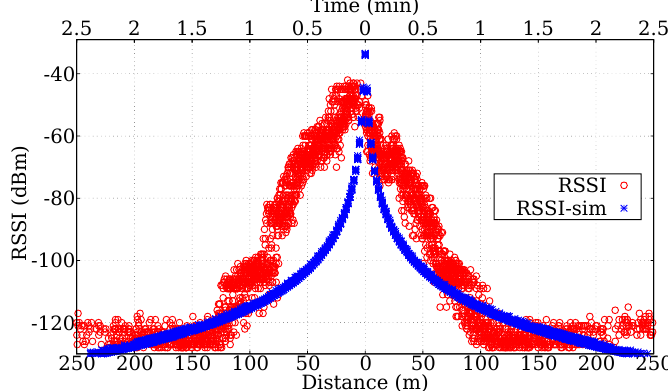
Figure 17. RSSI vs. distance—100m/min - simulated vs. practical.